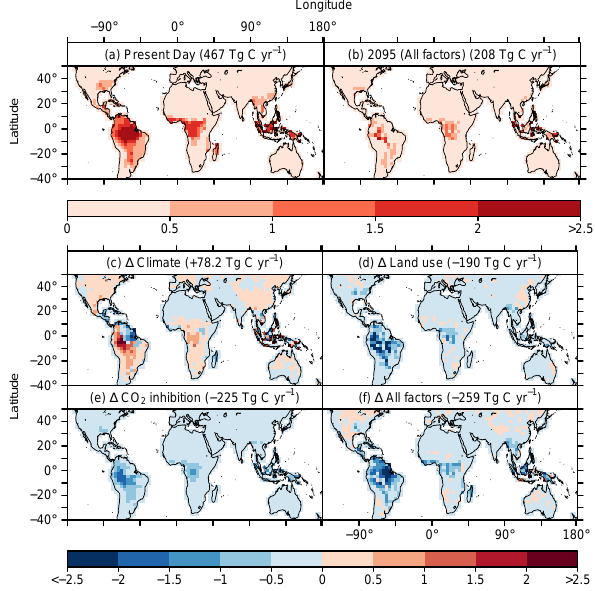
Fig. 2. Isoprene emissions (mgCm − 2 h − 1 ) generated using the SDGVM and a biogenic emissions model. (a) Present-day (2000), (b) with 2095 climate, land use and CO 2 inhibition, (c–e) change caused by each factor, (f) change with all factors combined. Quoted in the plot titles are total global isoprene emissions (a–b) and the change in this value (c-e).